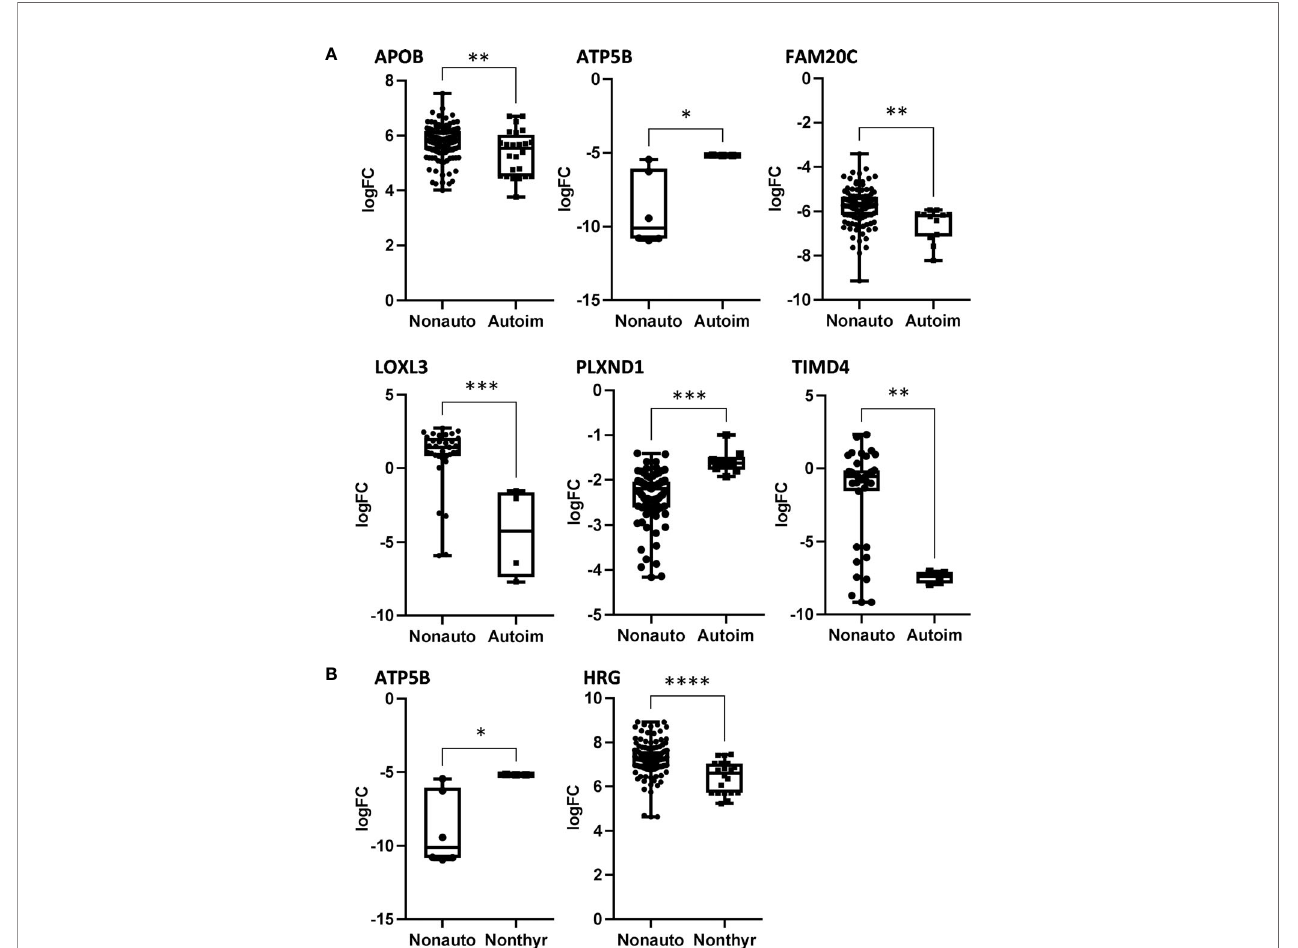
FIGURE 2 | The signi fi cantly altered proteins in bvFTD-autoimmune (A) and bvFTD-nonthyroid (B) compared to bvFTD-nonautoimmune serum that were enriched for the Uniprot keyword “ Glycoprotein ” . FC, fold change. *P < 0.05, **P < 0.01, ***P < 0.001, ****P <